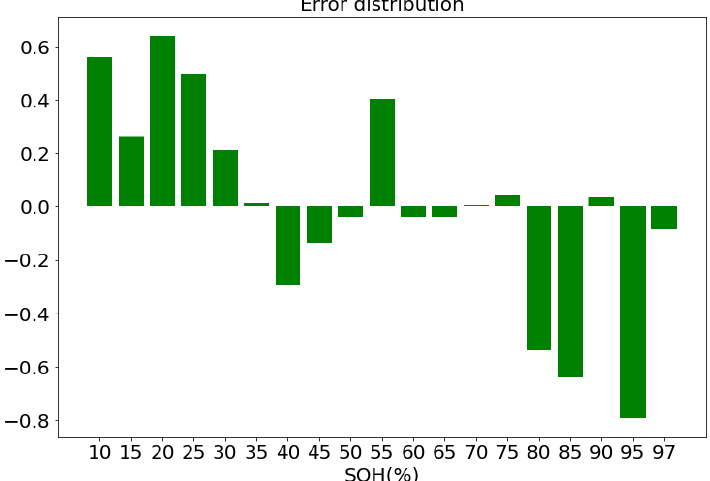
Figure 10. Error distributions on the validation set for different values of SoH and the correspond- ing